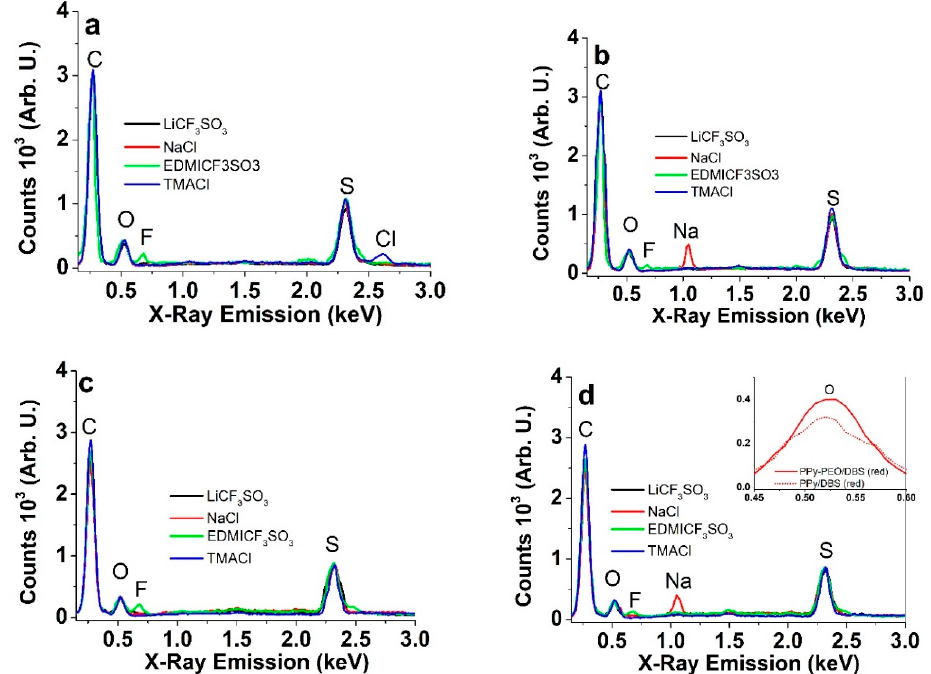
Figure 3. Energy-dispersive X-ray (EDX) spectra of PPy films in the oxidized (polarized 5 min at 0.65 V) and reduced state (5 min − 0.65 V) in aqueous electrolytes of LiCF 3 SO 3 (black), NaCl (red), EDMICF 3 SO 3 (green) and TMACl (blue): ( a ): oxidized PPy-PEO/DBS, ( b ): reduced PPy-PEO/DBS; ( c